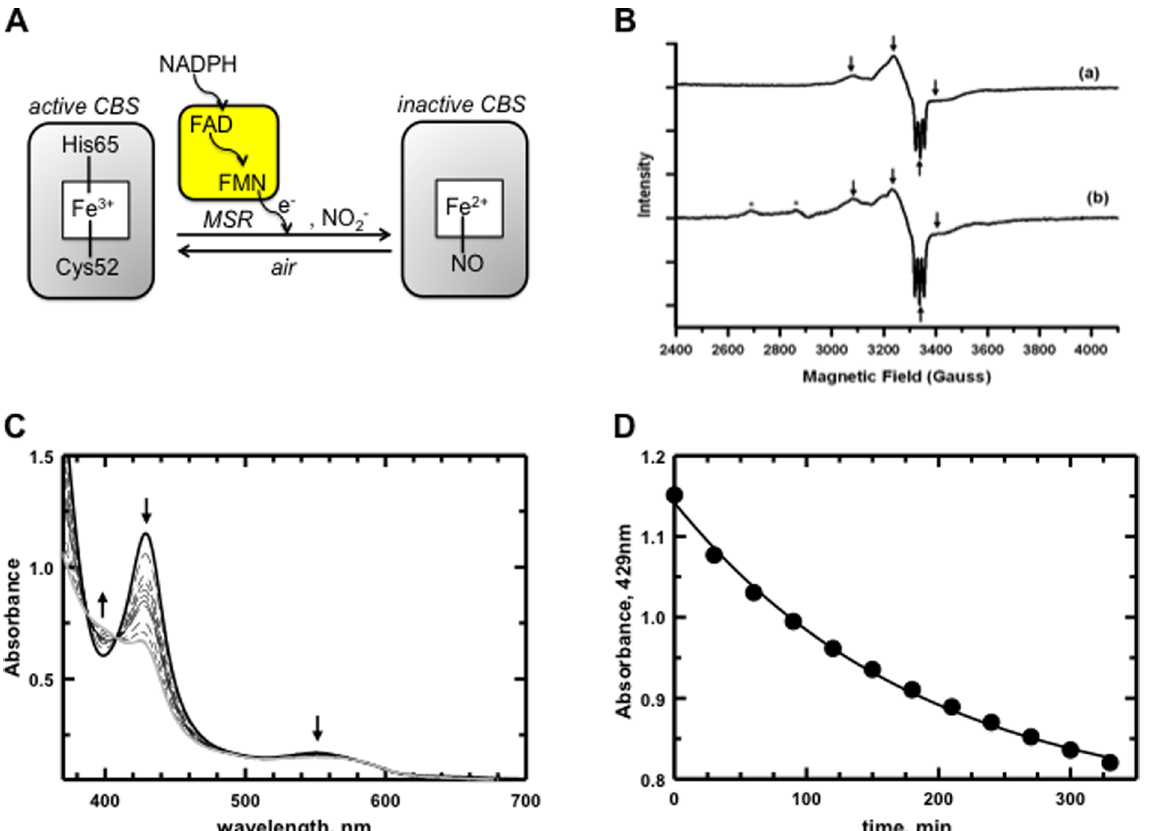
Figure 2. Model for and spectroscopic evidence of formation of Fe II -NO CBS in the presence of MSR/NADPH. ( A ) Fe III -CBS catalyzes the condensation of cysteine (Cys) and homocysteine (Hcy) to give H 2 S and cystathionine (Cyst). The latter is subsequently cleaved to give cysteine, which is utilized for glutathione (GSH) synthesis. In the presence of NADPH/MSR and nitrite, Fe II -NO CBS is formed, rendering CBS inactive. ( B ) EPR spectra of Fe II -NO CBS, obtained with Fe III -CBS (65 m M), treated with dithionite (6 mM) (upper) or NADPH (2 mM)/MSR (20 m M) (lower) and sodium nitrite (10 mM) in 0.1 M HEPES buffer, pH 7.4 at 37 u C. The spectra were recorded using the conditions described previously [26]. The arrows indicate g values of 2.17, 2.076, 2.008 and 1.97, respectively. The presence of additional EPR signals in the spectrum of NADPH/MSR-dependent CBS-catalyzed nitrite reduction can be attributed to the incomplete reduction of paramagnetic Fe III -CBS. (C) UV-visible spectra were recorded every 10 min under anaerobic conditions for the reaction between Fe II -CBS (generated by reduction of Fe III -CBS (10 m M) with MSR (2 m M)/NADPH (1 mM)) and nitrite (10 mM) in 0.1 M HEPES buffer, pH 7.4, at 37 u C. (B) Time-dependent conversion of Fe III -CBS (429 nm) to Fe II -NO-CBS (394 nm).